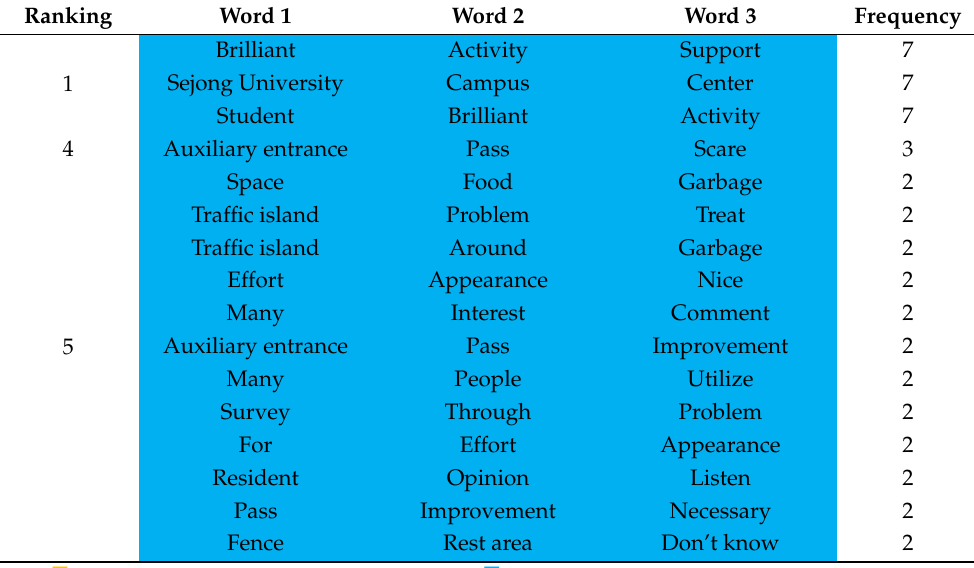
Table 7. Phrases of 3-g frequently used by residents.